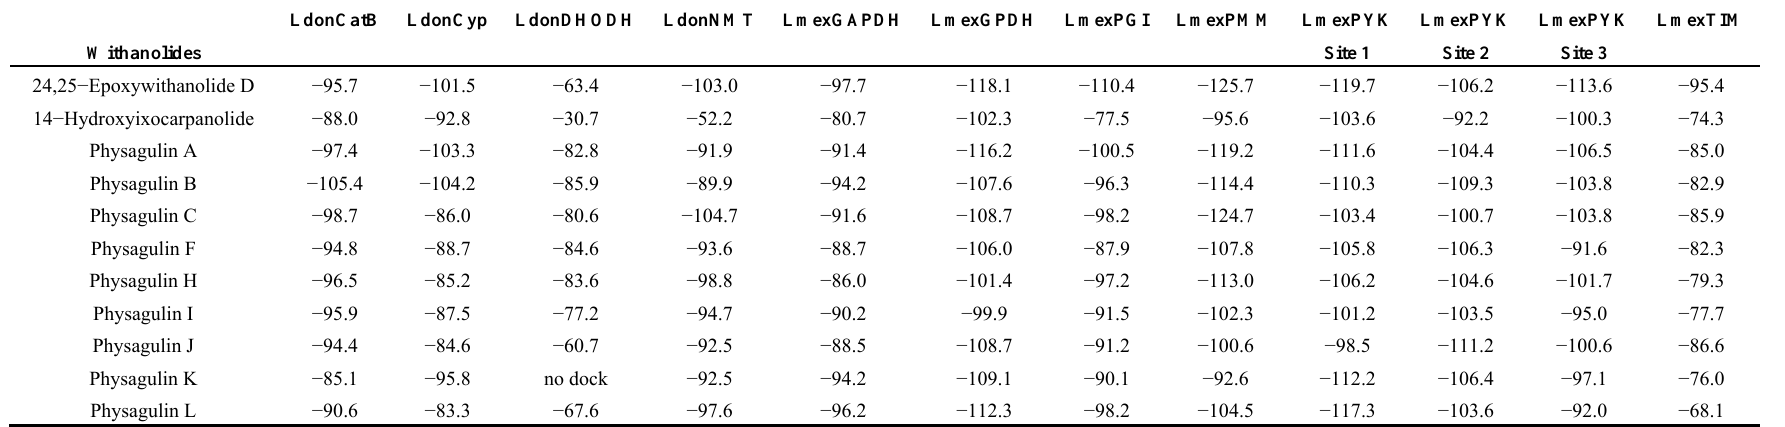
Table 33. MolDock docking energies (kJ/mol) of withanolides with Leishmania donovani and L. mexicana protein